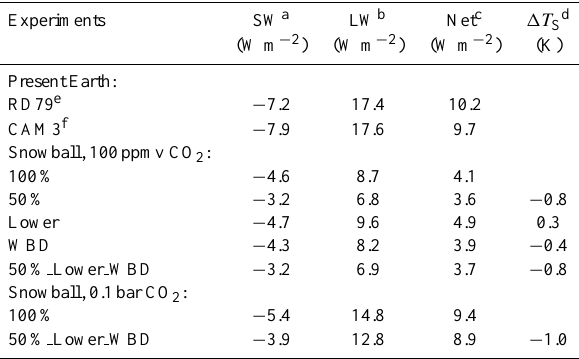
Table 1. Comparison of radiative effects of the stratosphere on the troposphere between the present Earth and the Snowball Earth with different ozone scenarios (see text for details). The stratosphere here is defined as the layer between the top of the model (2.0hPa) and the level of 170hPa. All of the values are for global and annual